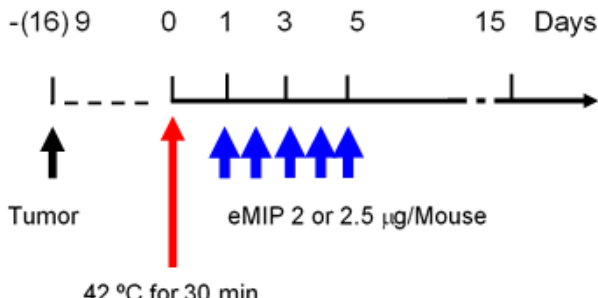
Figure 5. Experimental